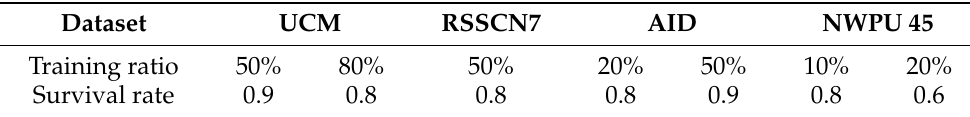
Table 4. The setting of survival rate in different classification